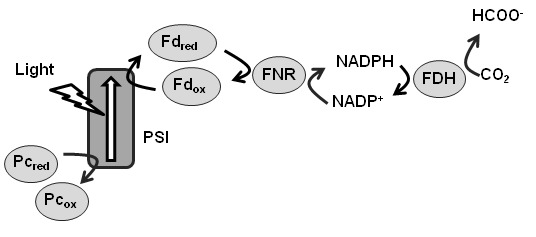
The proposed system for light-driven formateproduction.